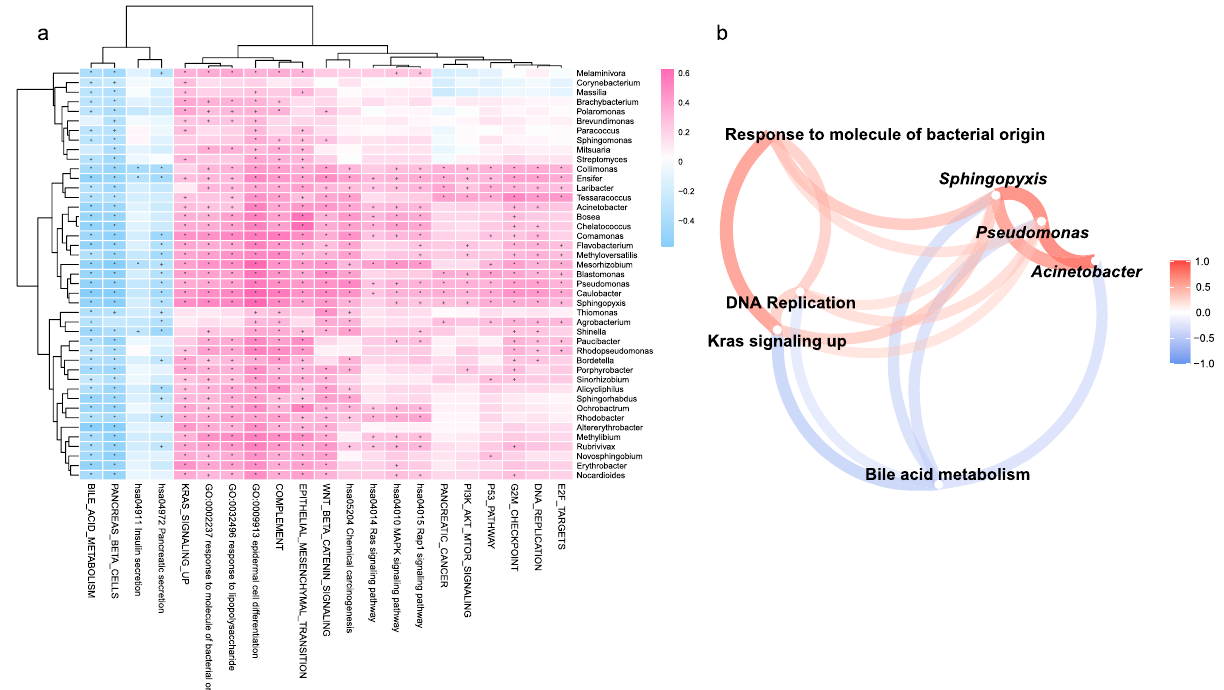
Fig. 5 The tumor microbiome is associated with host functional modules. a Heatmap of Pearson ’ s correlation between 21 functional modules (columns) and 43 bacterial genera (rows). The color represents the coef fi cient of correlation. + denotes the p values <0.05, and * denotes the p values <0.01. b Correlation network between 4 functional modules and 3 key genera re fi ned from ( a ). Red and blue edges denote Pearson ’ s correlation coef fi cients >0.3 and < − 0.3,